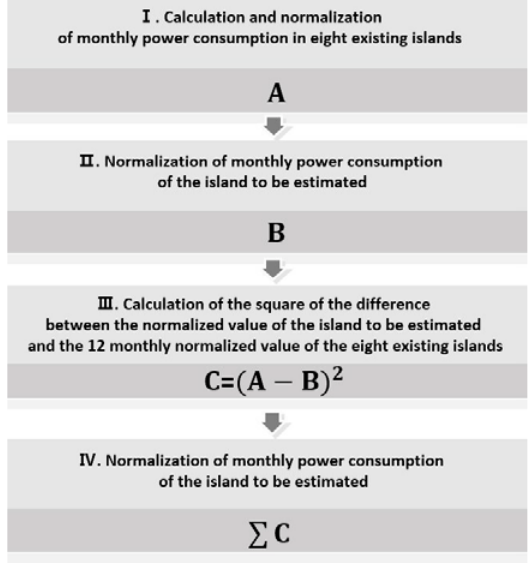
Figure 2. Estimation process for load pattern.